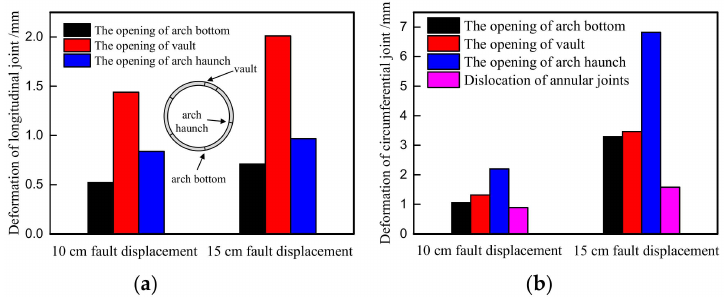
Figure 14. Deformation of segment joints under normal fault dislocation. ( a ) Deformation of longitu- dinal joints and ( b ) deformation of circumferential